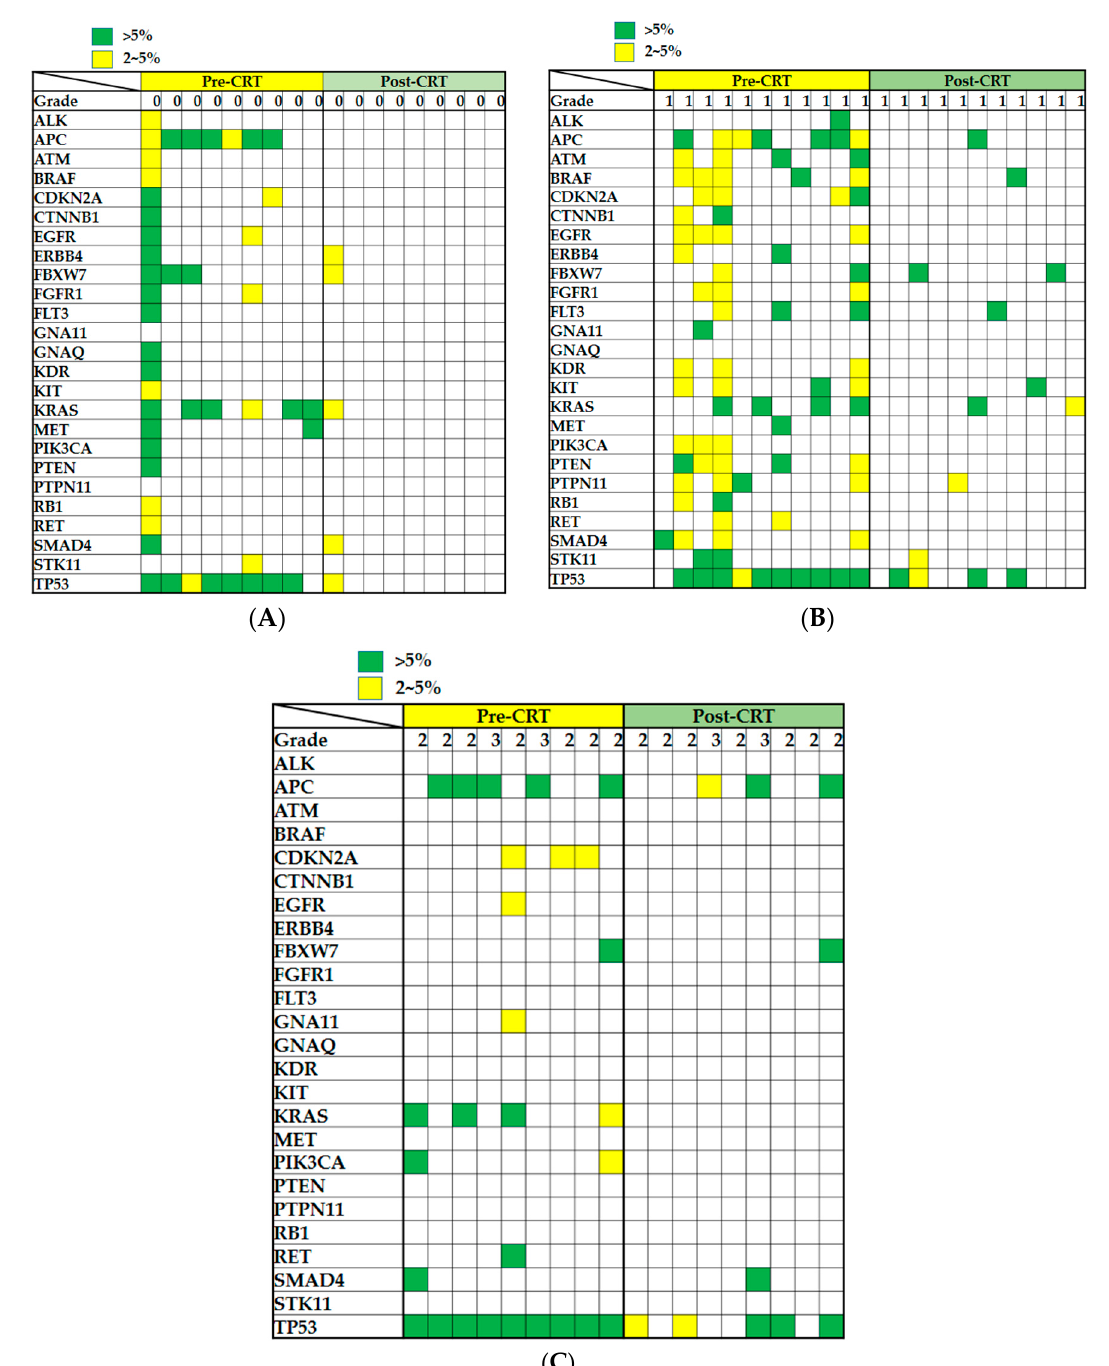
Figure 4. Gene mutation status was examined in specimens from patients with rectal carcinoma before and after nCRT. ( A ) Mutation profiles of biopsy-collected specimens (pre-nCRT) and surgery-collected specimens (post-nCRT) from nine patients with rectal carcinoma with tumor regression grade 0. ( B ) Mutation profiles of biopsy-collected specimens (pre-nCRT) and surgery-collected specimens (post-nCRT) from 11 patients with rectal carcinoma with tumor regression grade 1. ( C ) Mutation profiles of biopsy-collected specimens (pre-nCRT) and surgery-collected specimens (post-nCRT) from nine patients with rectal carcinoma with tumor regression grade 2–3. A green square indicates that a mutation with a frequency of >5% was detected in a gene, a yellow square indicates that a mutation with a frequency of 2–5% was observed in a gene, and an empty square indicates that no relevant mutation was observed for the gene. Table 3. Gene mutations retained in rectal carcinoma after nCRT.